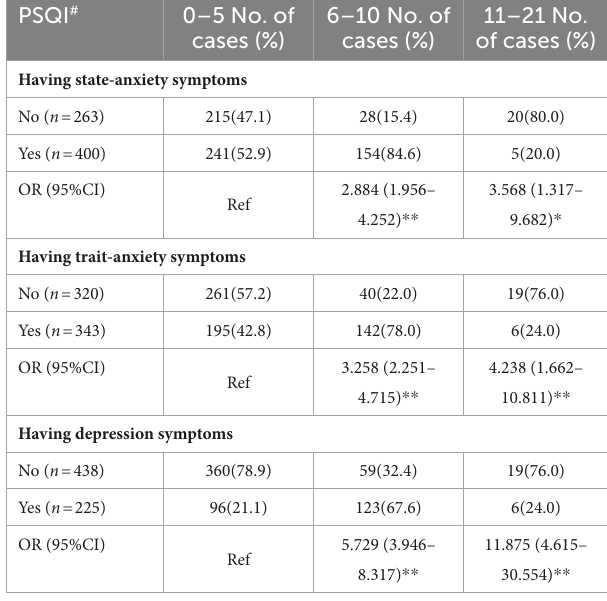
TABLE 4 Association between sleep quality and anxiety, depression symptoms ( n =